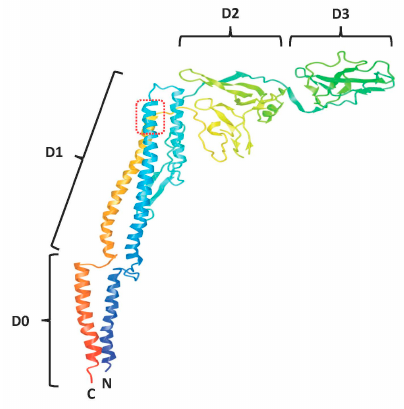
Figure 1. Domain structure of full-length flagellin. Image derived from PDB ID: 1UCU [38] visualized with iCn3D (https://www.ncbi.nlm.nih.gov/Structure/icn3d/full.html) and modified to indicate D0, D1, D2 and D3 domains. Residues 89–96 (QRVRELAV) in the D1 domain are encircled by a red dashed line.